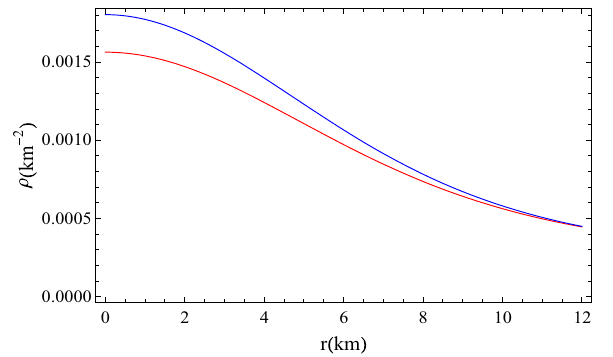
Fig. 14 Variation of energy-density ( ρ c ) with r for PSR J0348+0432 considering β = 1 and matter distribution following Chaplygin EoS [( α = 0 (blue) and α (cid:5)= 0 (red)]